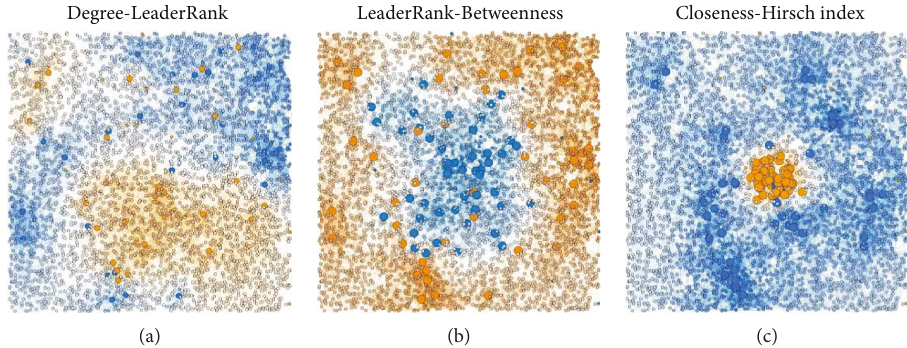
Figure 5: Three opinion di ff usion benchmarks highlighting the fi nal opinion coverage over the Mesh dataset ( N = 10,000 ). Orange nodes are in fl uenced more by the fi rst ranking method, and blue nodes are in fl uenced more by the second ranking method; whiter nodes are closer to indecision (50%); larger nodes represent seeders (1% of N ). Table 4: Comparison between individual SIR and our simultaneous competition-based benchmark in terms of how well ranking methods are di ff erentiated. Δ is the di ff erence (%) between the most and least e ffi cient ranking methods; Δ min − max ranking methods on each dataset. Higher di ff erences are